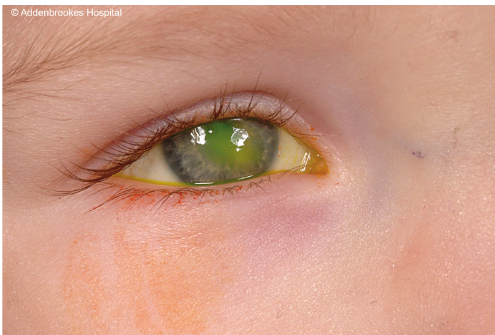
Figure 1: Slit lamp photograph of right eye cornea showing the central persistent epithelial defect measuring 2 × 4mm with stromal